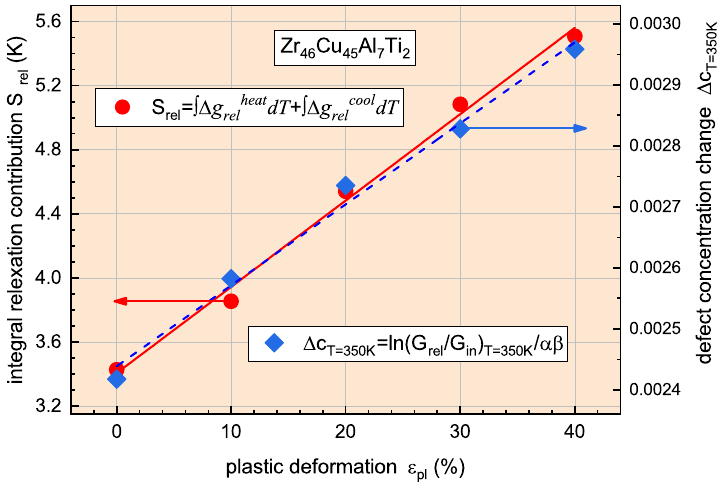
Figure 4. The integral magnitude of the relaxation contribution to the shear modulus S rel calculated with Equation (9) and the change of the defect concentration ∆ c determined according to Equation (8) as a function of plastic deformation ε pl . The lines give square least-fit approximations. It is seen that ∆ Srel is proportional to ∆ c .